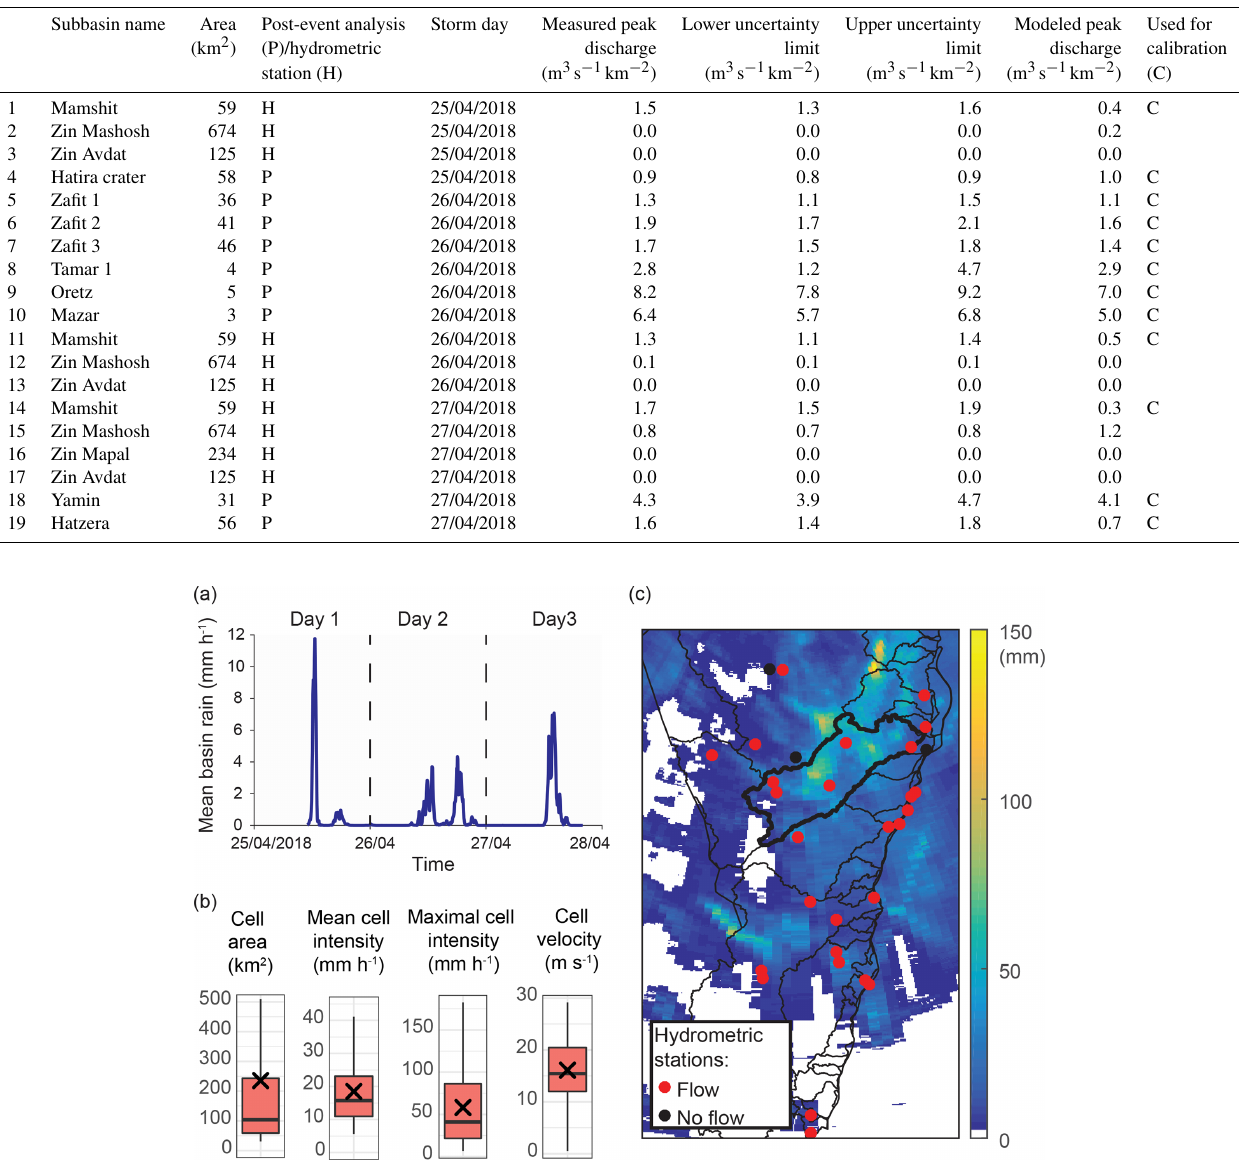
Figure 2. Properties of the 25–27 April 2018 rainstorm. Panel (a) shows the 5min rain intensity spatially averaged over the Zin basin. (b) Rain-cell area, mean and maximal rain-cell intensity, and rain-cell velocity calculated over the Zin basin. Crosses represent the mean, horizontal lines are the median, colored areas represent the narrowest 50% of the data, and the whisker limits represent the minimal and maximal values except when 150% of the interquartile range is exceeded. (c) Total storm rain depth from the radar analysis and location of hydrometric stations. Stations that exhibited at least one flash flood during the rainstorm are marked in red. The Zin basin is marked by a bold